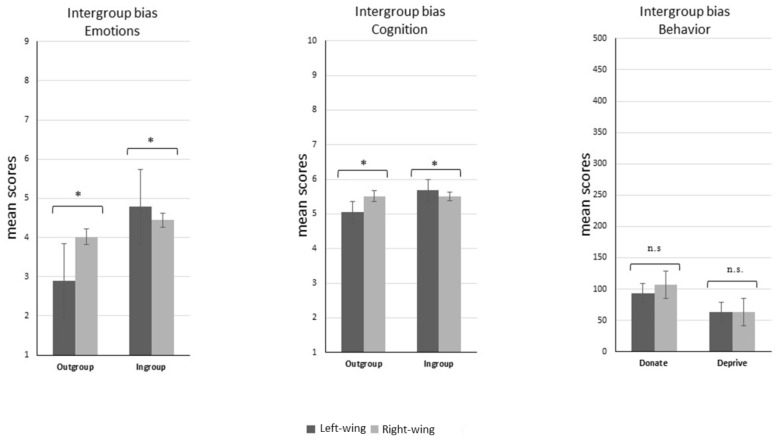
Intergroup bias on Emotions, Cognition and Behavior. Comparisons of the mean scores between left and right-wing participants on the three measures of intergroup bias: emotions, cognition and behavior. A significant difference between the two groups was found in emotions and cognitions (all ps < 0.03), but not in behavior (p = 0.79). This last measure was indexed in Donation using the formula ingroup donation – outgroup donation and in Deprivation using the formula ingroup deprivation – outgroup deprivation. ∗p < 0.03.